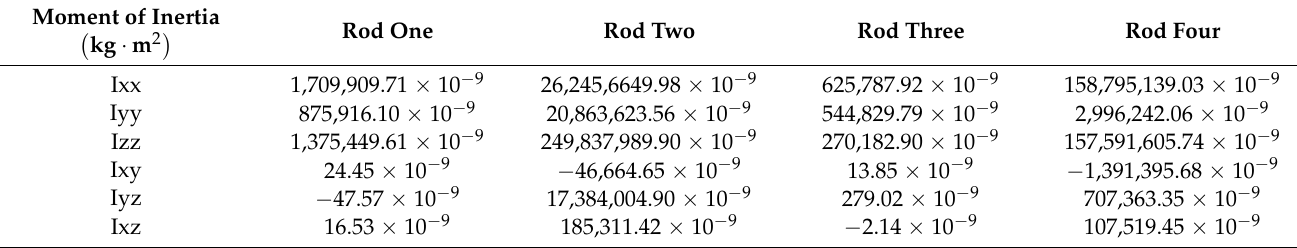
Table 4. Connecting rod inertia of humanoid